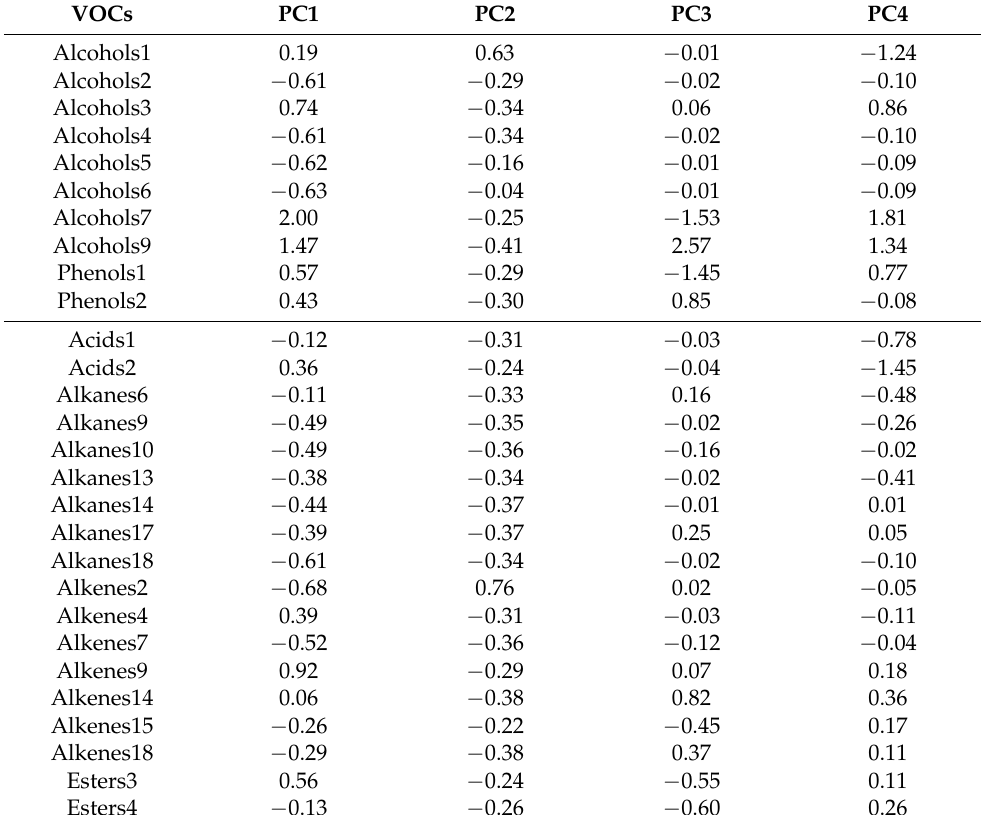
Table 3. Principal component loading